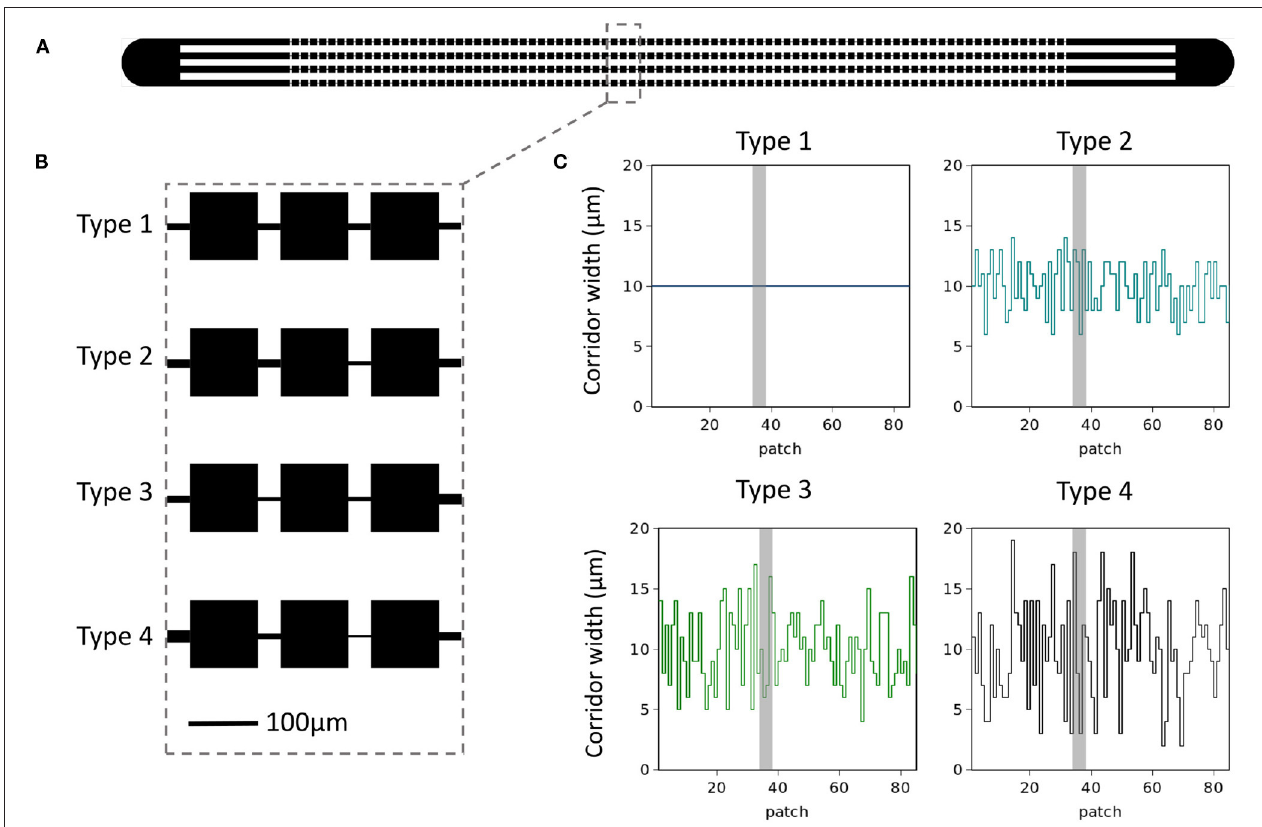
FIGURE 1 | Microfluidics device. (A) A sketch of the microfluidics device with single inlets on each side leading into four parallel habitat landscapes. (B) Zoom-in view of patch-corridor structure in each of the four parallel landscapes. For type 1 corridor width is kept constant at 10 µ m. Types 2–4 the average width is also 10 µ m with variance around the mean increasing from type 1 to 4 as σ 2 = 0,4,9,16 µ m 2 . This can be appreciated in (C) where we show the pattern of corridor widths used for each landscape type. Grey shading indicates location of